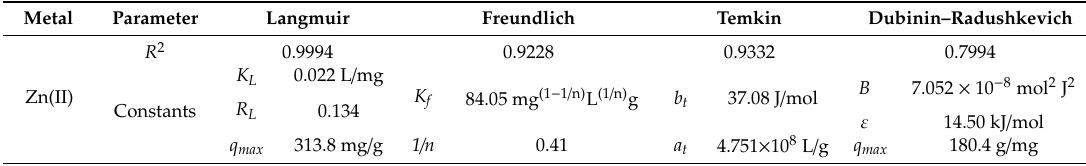
Table 3. The R 2 and constant values for the adsorption isotherm models of Zn(II).